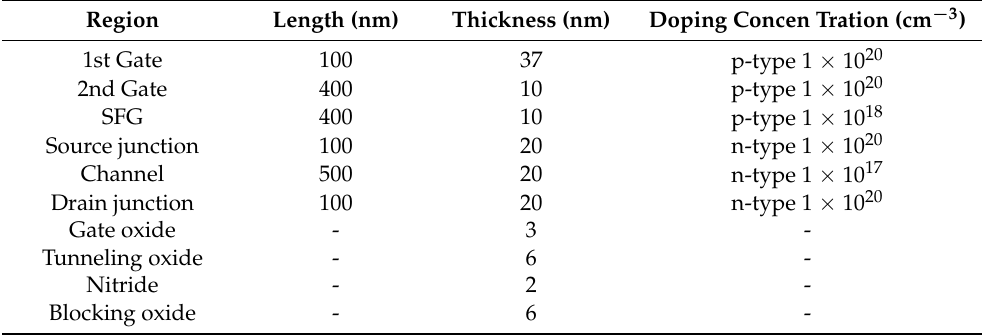
Figure 3. Mesh structure of the simulated device with notations of the terminals. Table 1. Critical dimensions and process parameters in the designed semi-floating-gate synaptic transistor (SFG S T).